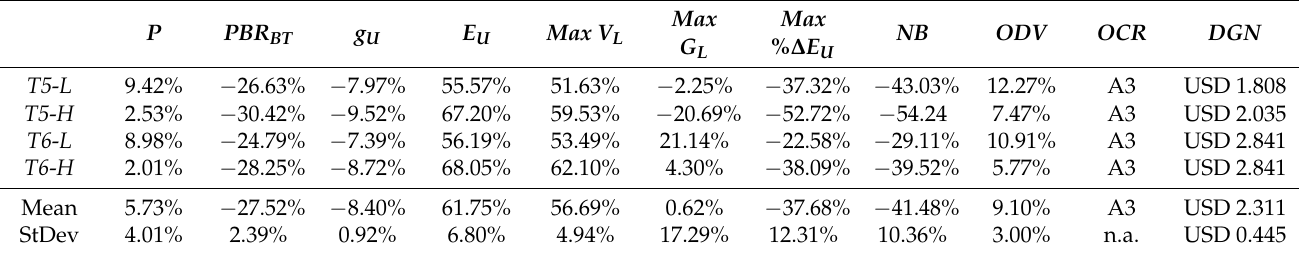
Table 7. NPs Versus PTs for the Period of